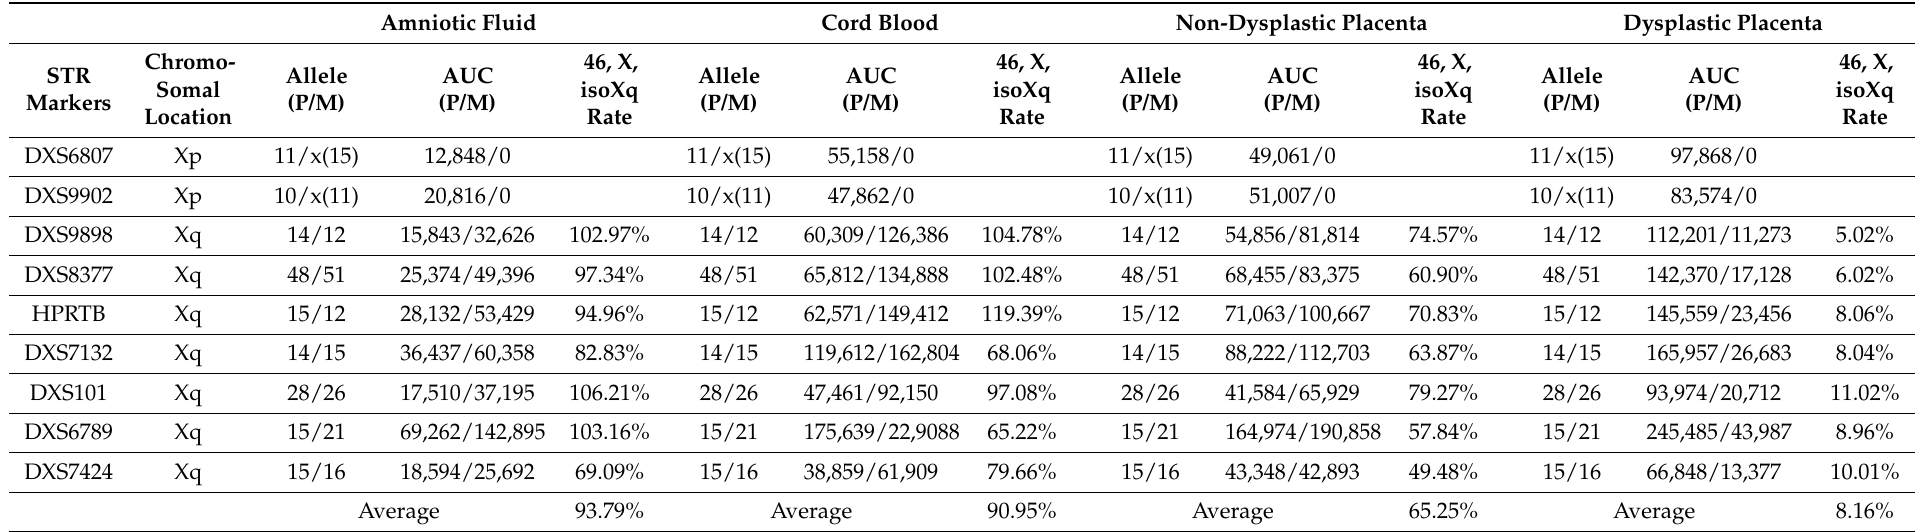
Table 3. Mosaic analysis of 46, X, iso(Xq) and 45, X using STR markers from sex